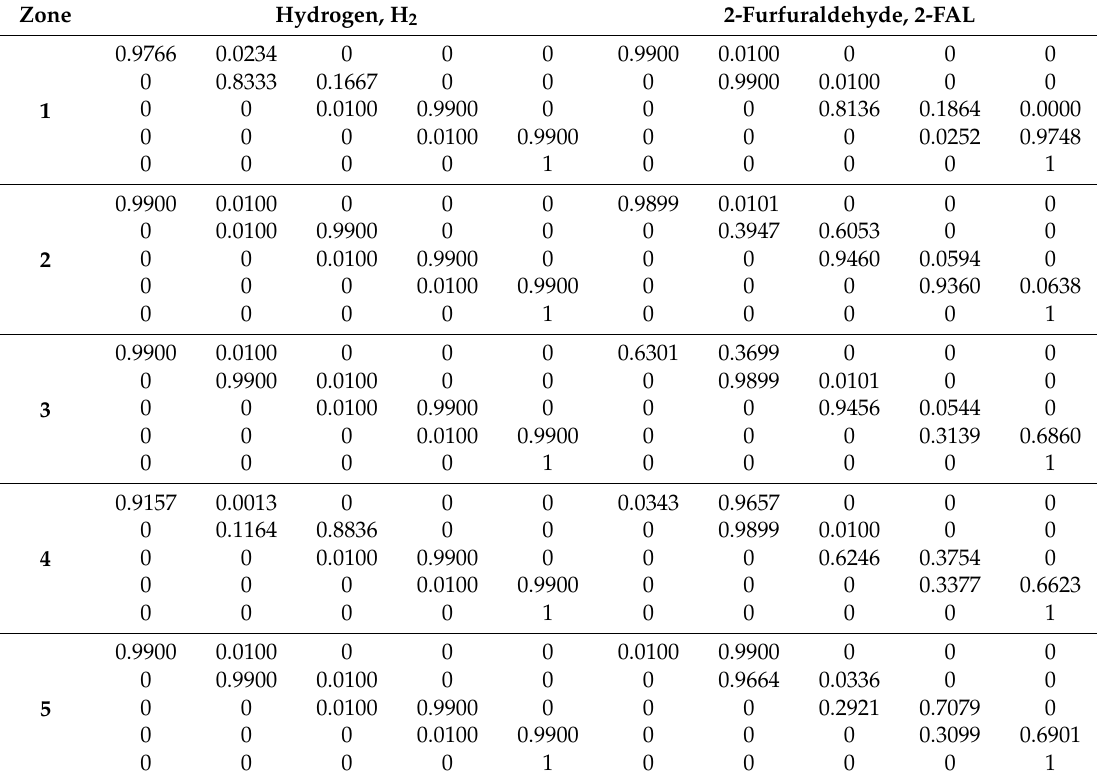
Figure 3. Distribution of oil samples used in case study. Table 3. Transition matrix for hydrogen and 2-furfuraldehyde according to zone.